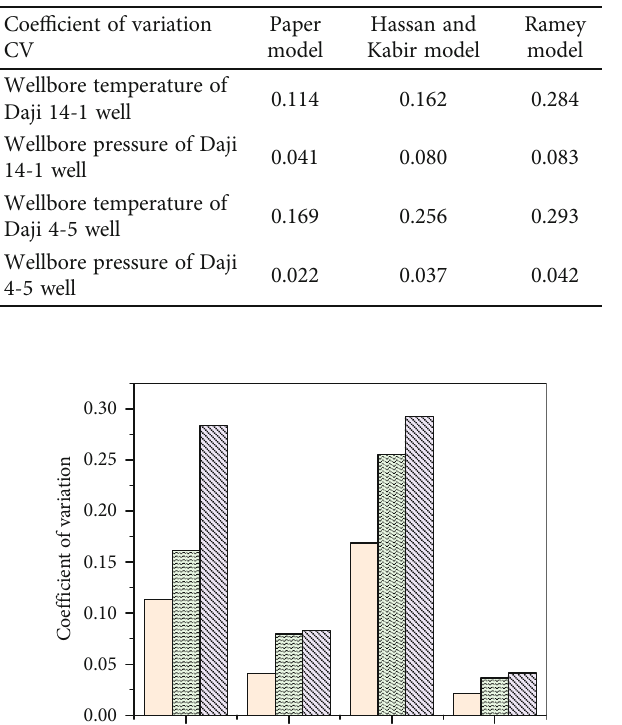
Table 2: Coe ffi cient of variation of each model.